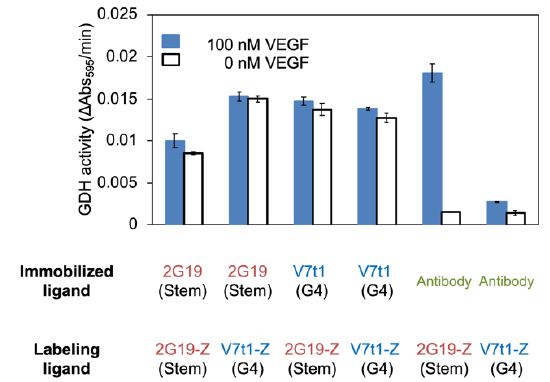
Figure 1. Investigation of aptamer and antibody combinations for the sandwich assay. To capture VEGF, aptamers (2G19 or V7t1) or anti-VEGF antibody (BAF293) was immobilized on a streptavidin-coated microtiter plate. As the detection ligand, ZF-GDH-labeled aptamers (2G19-Z or V7t1-Z) were used. Residual GDH activity on the plate was detected with colorimetric redox dye. Error bars indicate the standard deviation (n = 3).